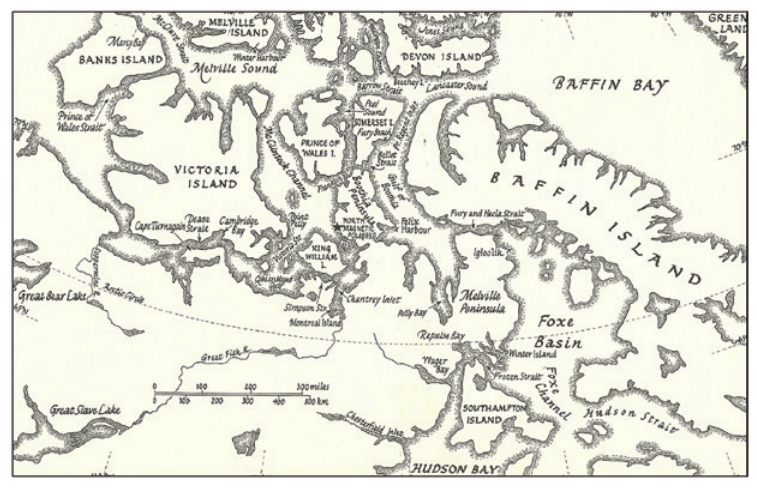
Figure 1. The North-West Passage. Source : Map drawn by Reginald Piggott for The Quest for the Northwest Passage , by Glyn Williams, published by the Folio Society, 2007. Reproduced by